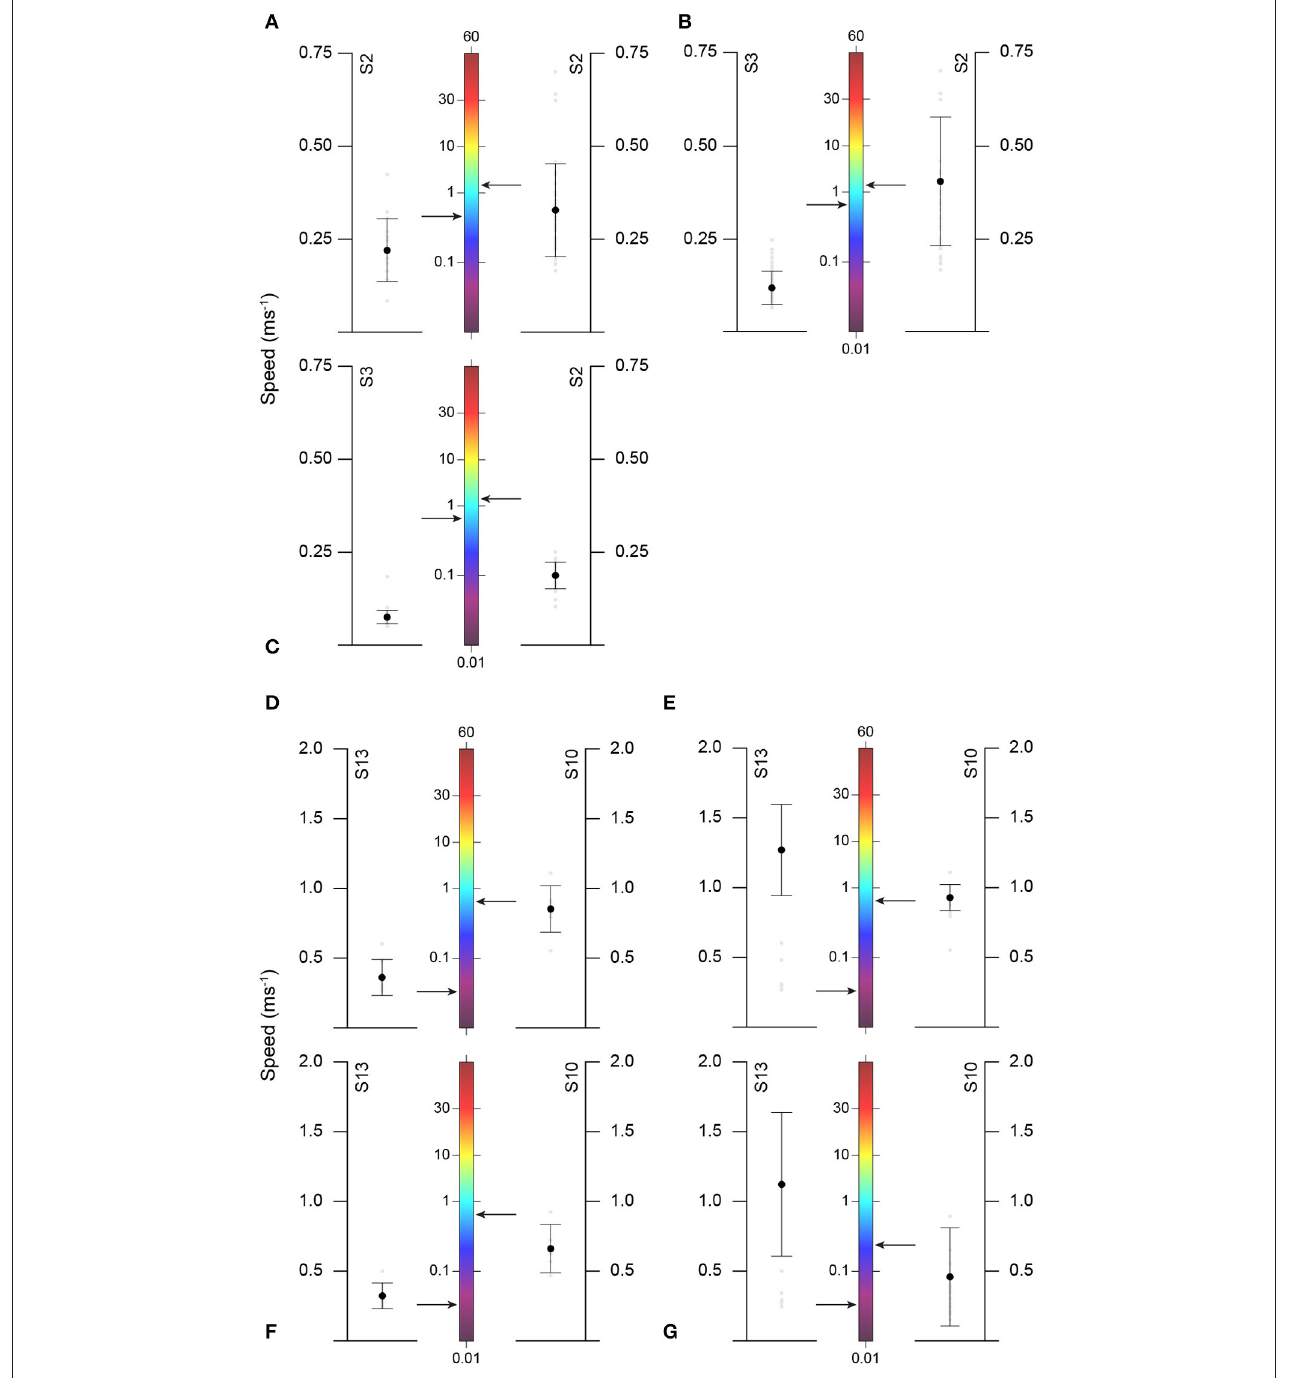
FIGURE 5 | Comparison of mean ( ± SD) ascent and descent speeds of basking (A–C) and blue (D–G) sharks with chlorophyll a mean concentration (arrow) for different time periods/sharks. Ascent speeds for V- (A,D) and U-shaped (C,F) dives; Descent speeds for V- (B,E) and U-shaped (G) dives.